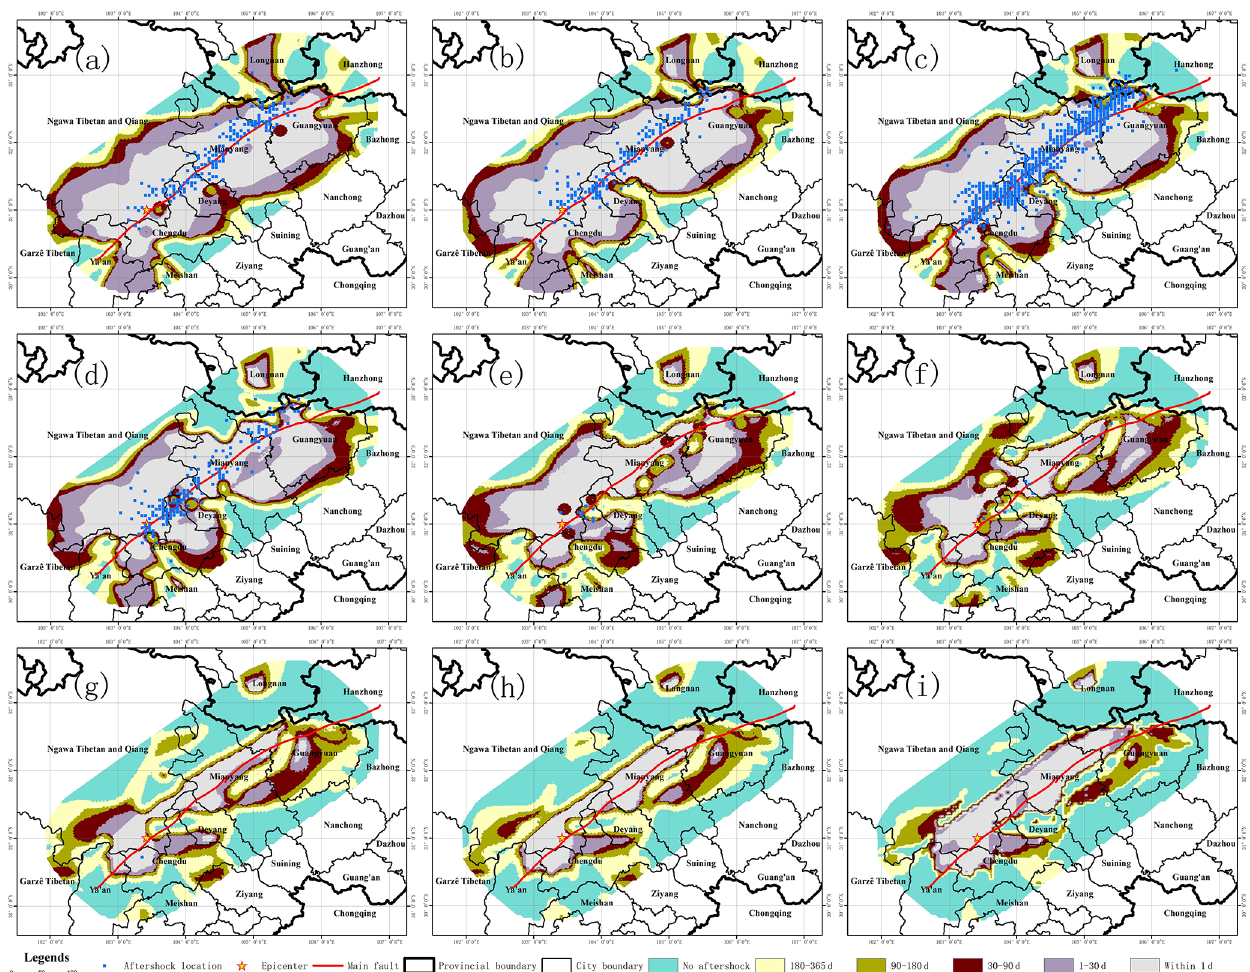
Figure 8. Aftershock hysteresis effect of the Wenchuan earthquake in different depths. Panels (a) through (i) show the aftershock hysteresis effect of the Wenchuan earthquake for depth sections of 2.5, 7.5, 12.5, 17.5, 22.5, 27.5, 32.5, 37.5 and 42.5km, respectively.